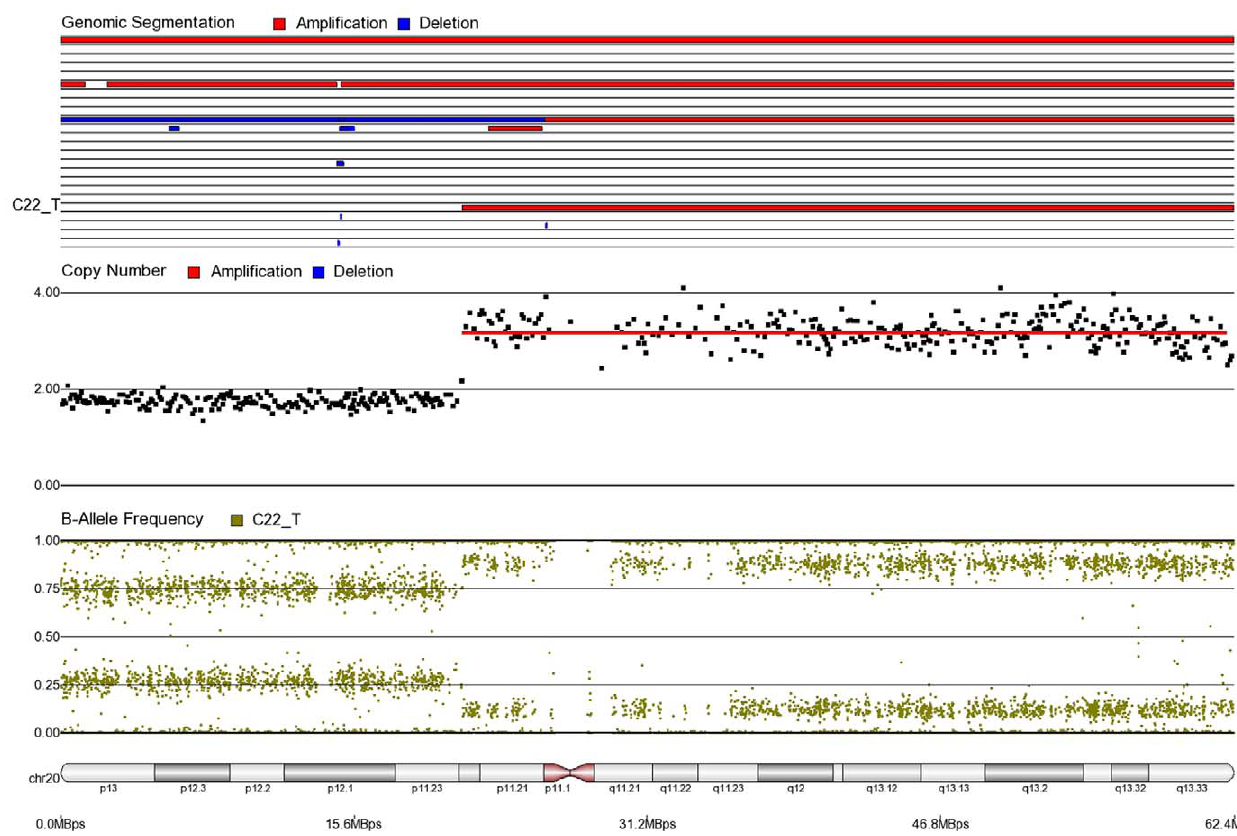
Figure 7. Mosaic isotrisomy in chromosome 20q of CRC tissue sample C22_T.